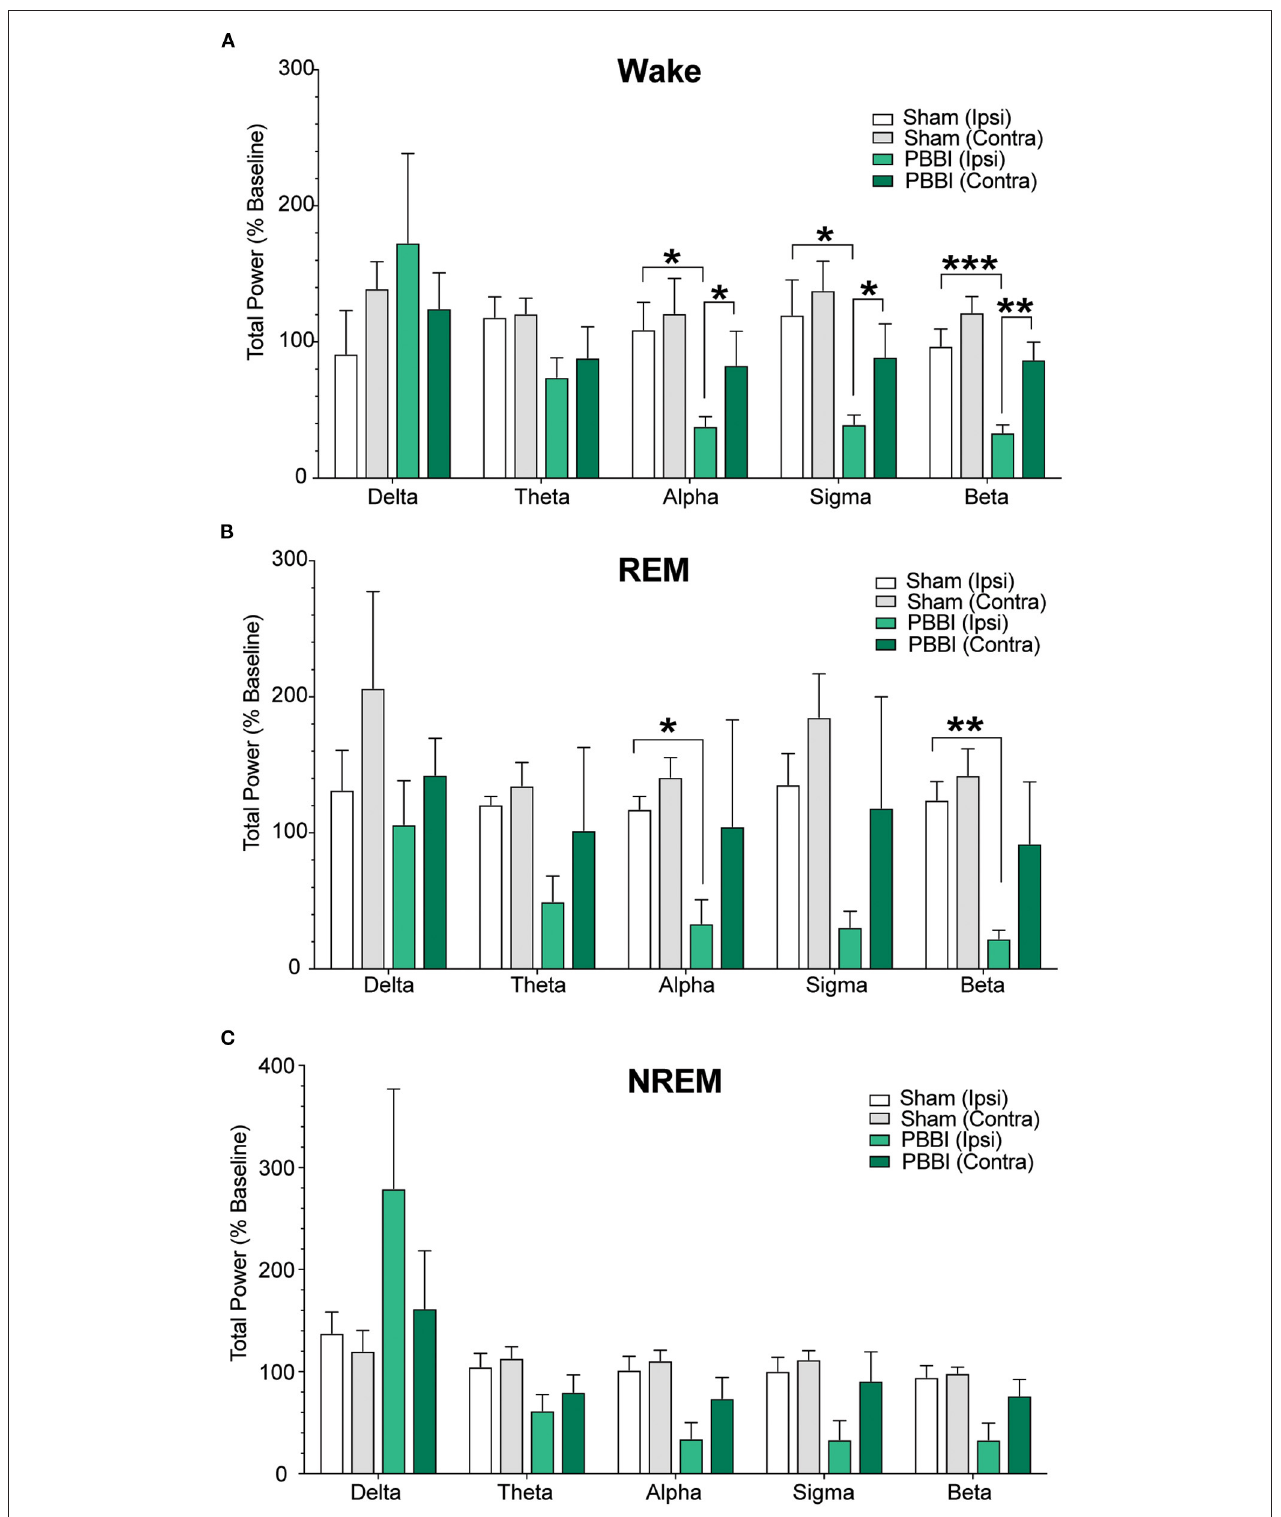
FIGURE 6 | Comparison of relative total power between PBBI and sham animals. Power data were extracted from baseline and post-injury periods from both hemispheres and binned into frequency bands and sorted according to vigilance states: (A) wake, (B) REM, and (C) NREM sleep. PBBI rats showed significant reductions in relative power at higher frequencies with trends toward increased delta power. N = 5 PBBI / 5 sham. All data are depicted as the percentage of baseline mean ± SEM (*** p < 0.001, ** p < 0.01, * p < 0.05).